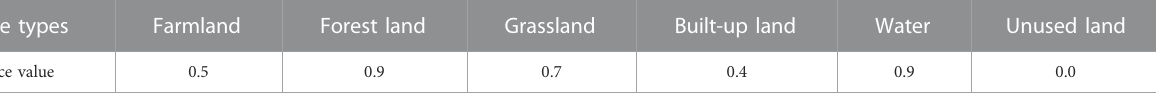
TABLE 3 Resilience value of land use types in Dianchi Lake basin.